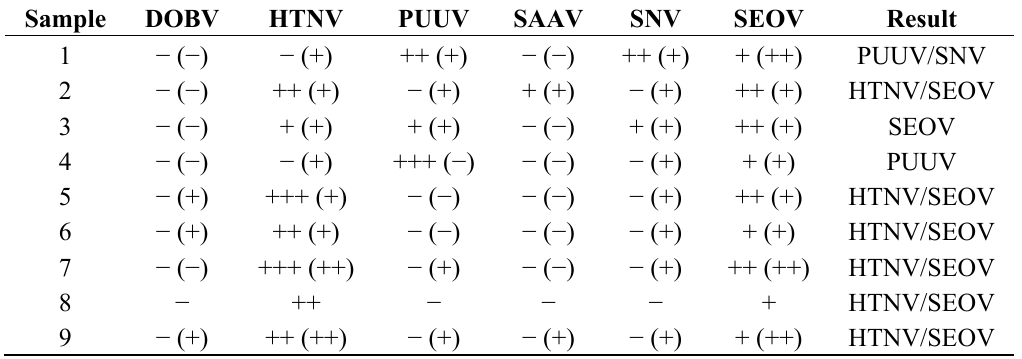
Table 1. Pattern of reactivity for immunofluorescence assay at 1:100 dilution in sera and (saliva). Sample